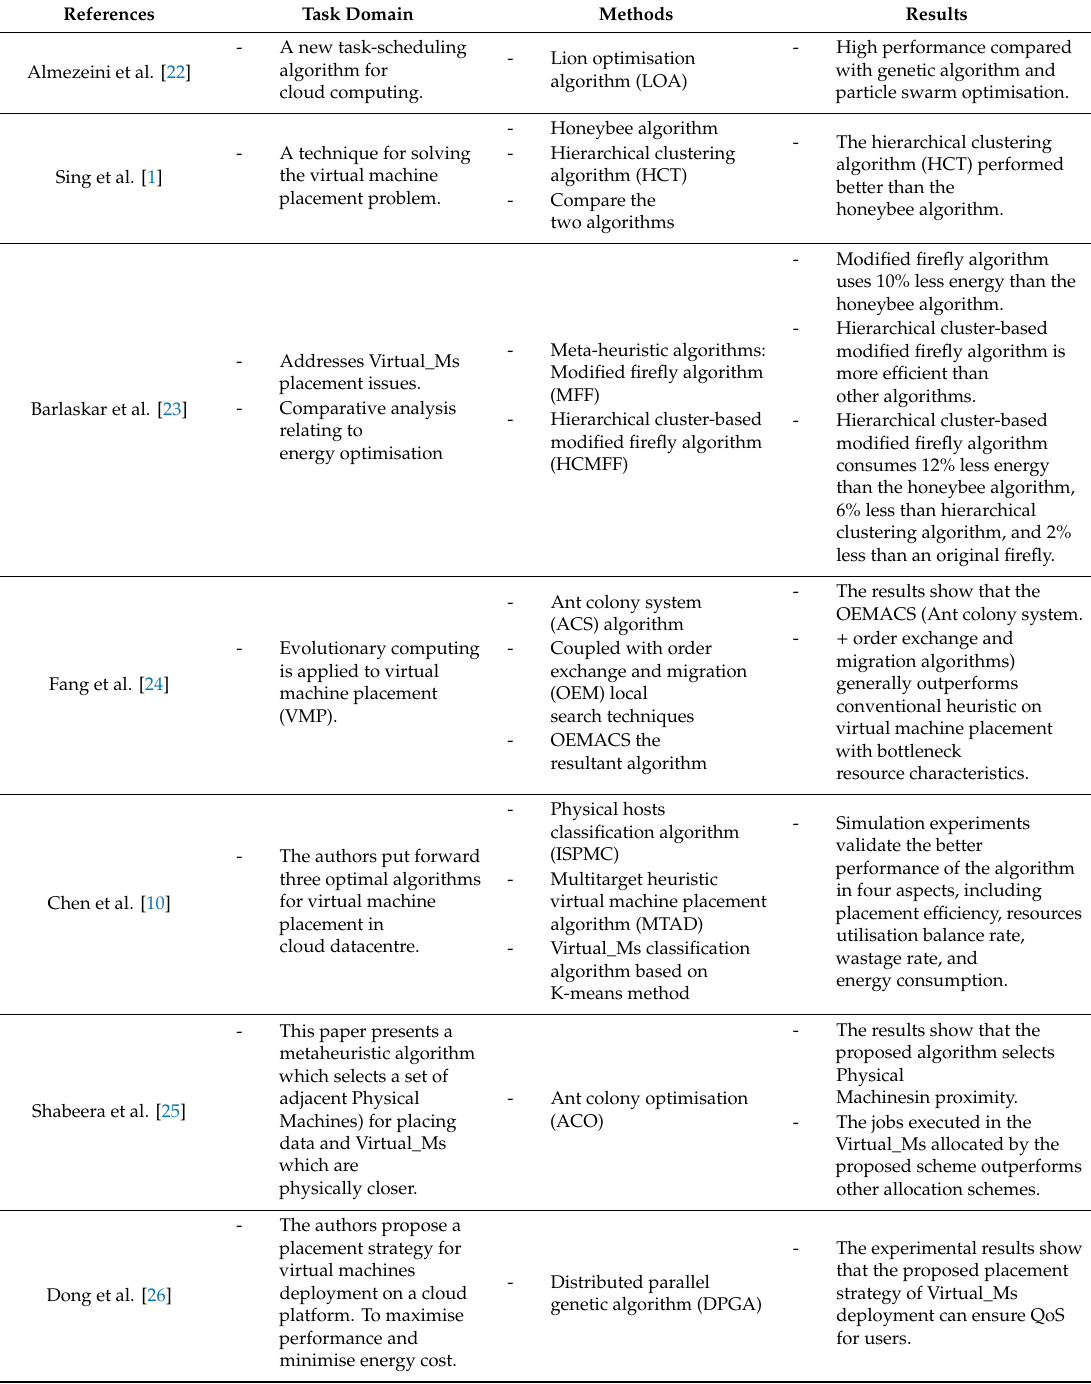
Table 1. Related work